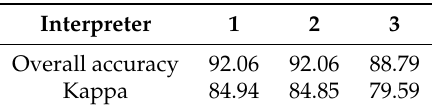
Table 9. Photo-interpretation of the street-level imagery compared to the ground-truth for the three photo-interpreters.